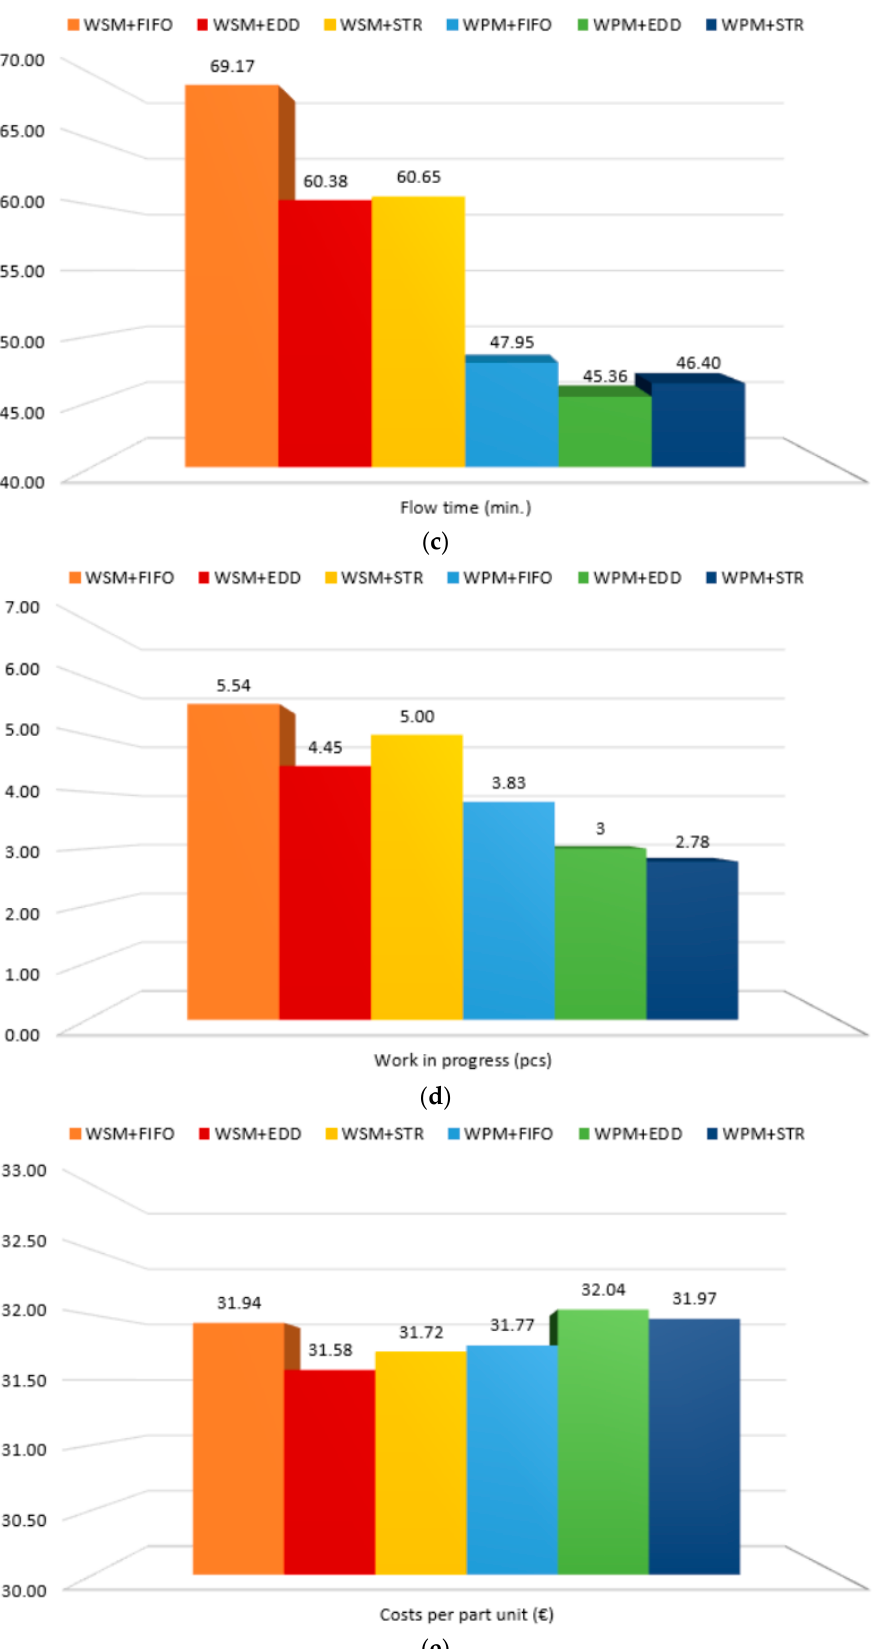
Figure 4. The comparison of production goals when applying two multi-criteria methods with different priority rules. ( a ) Number of products; ( b ) machine utilization; ( c ) flow time; ( d ) work in progress; ( e ) costs per part